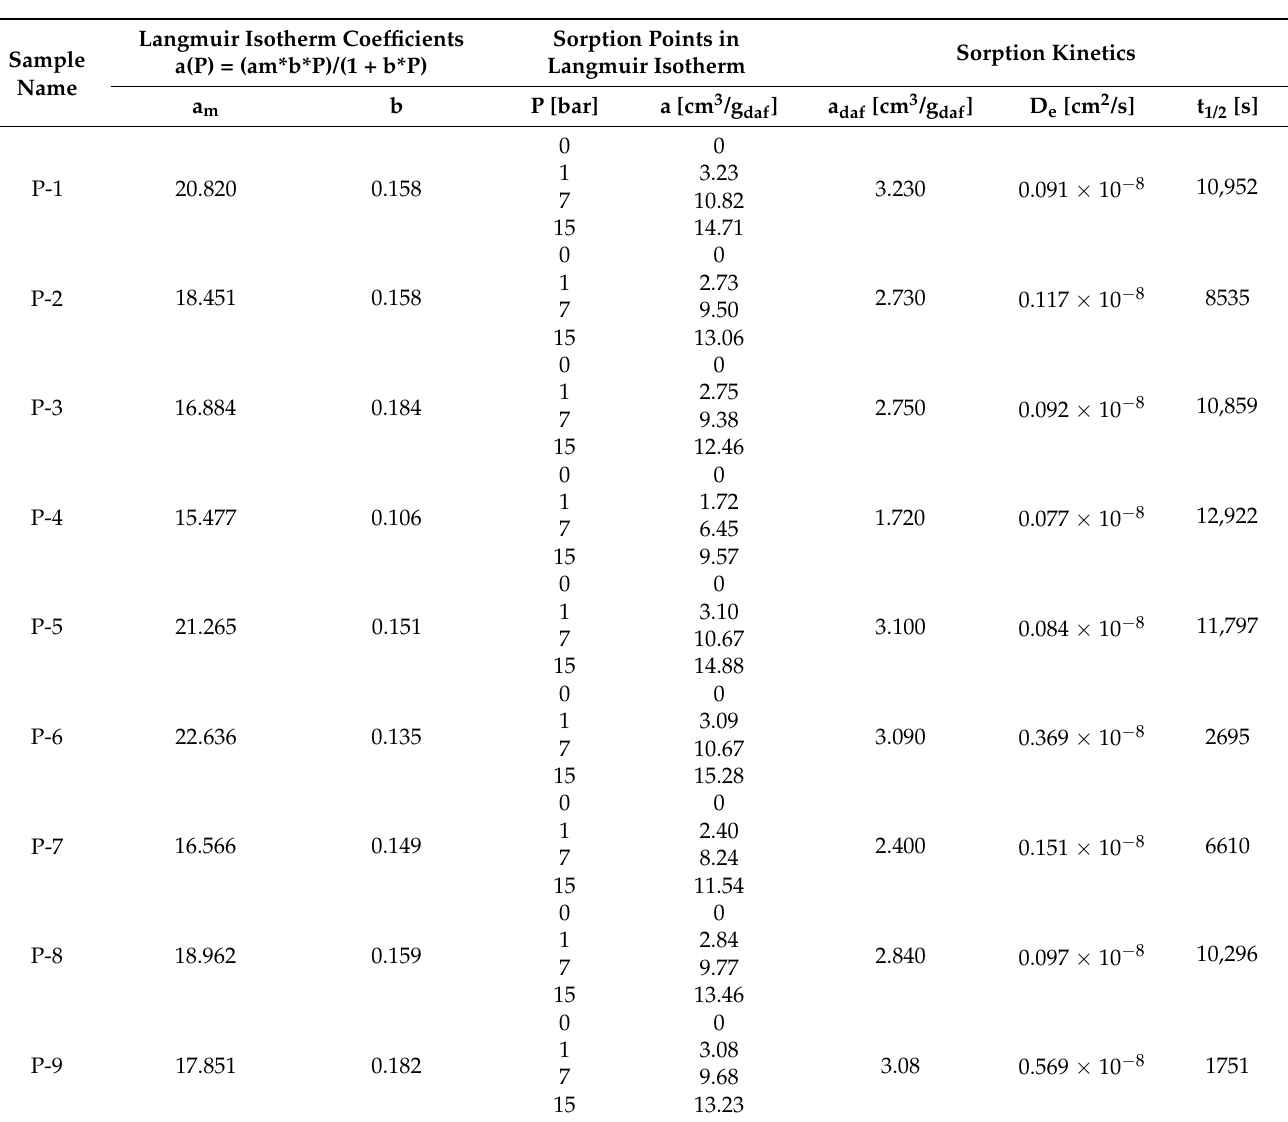
Table 4. Summary of the results of methane sorption analyses: sorption isotherms and sorption